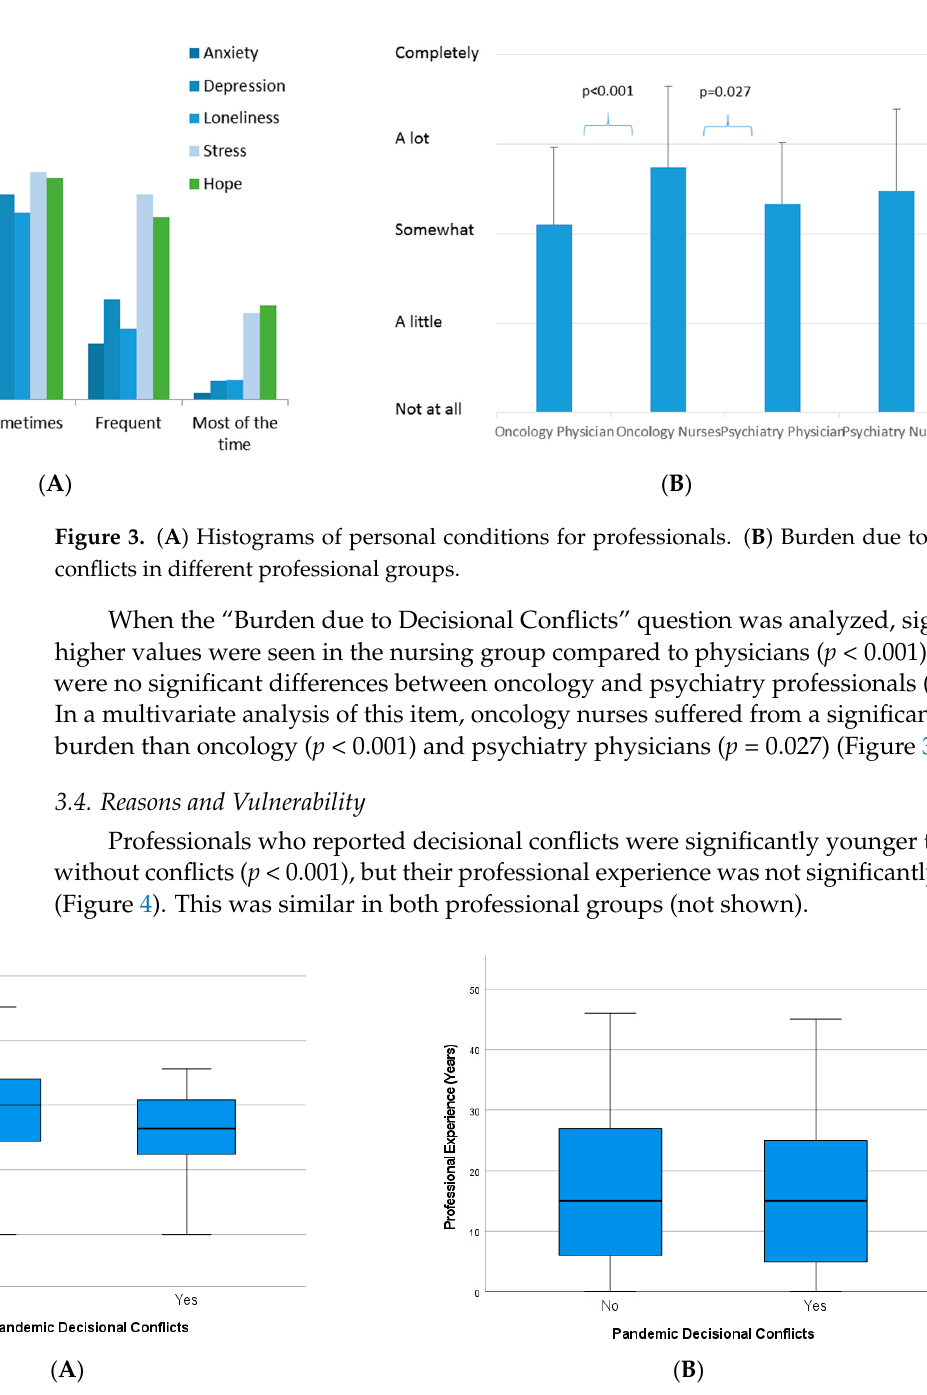
Table 2. Prediction by nominal regression analysis for “Decisional Uncertainty”: (A) Likelihood–